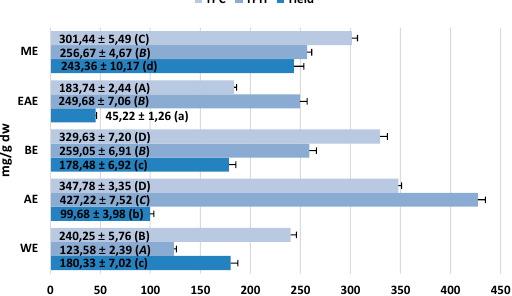
Figure 2. Total content of phenolic compounds (TPC, TPH) and extraction yields of the G. procumbens stem dry extracts. Data expressed as means ± SD ( n = 3) per dw of the extract (TPC, TPH) and the plant material (Yield). For each parameter, different letters in parentheses indicate significant differences ( p < 0.05).